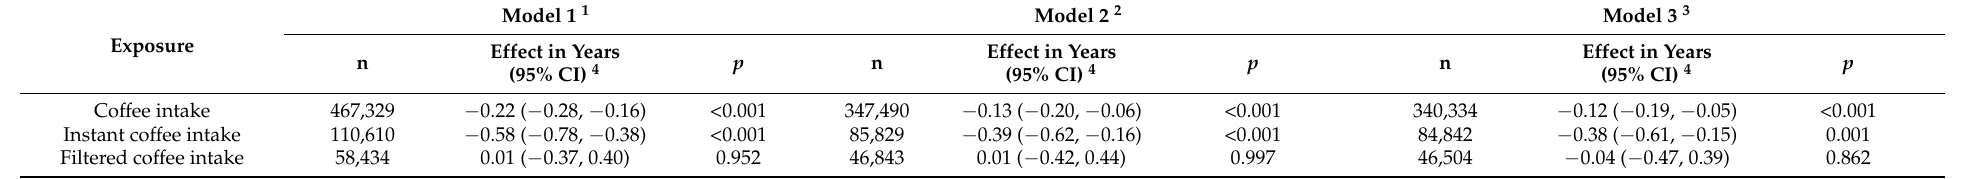
Table 2. Association of coffee consumption and telomere length in multivariable linear regression.